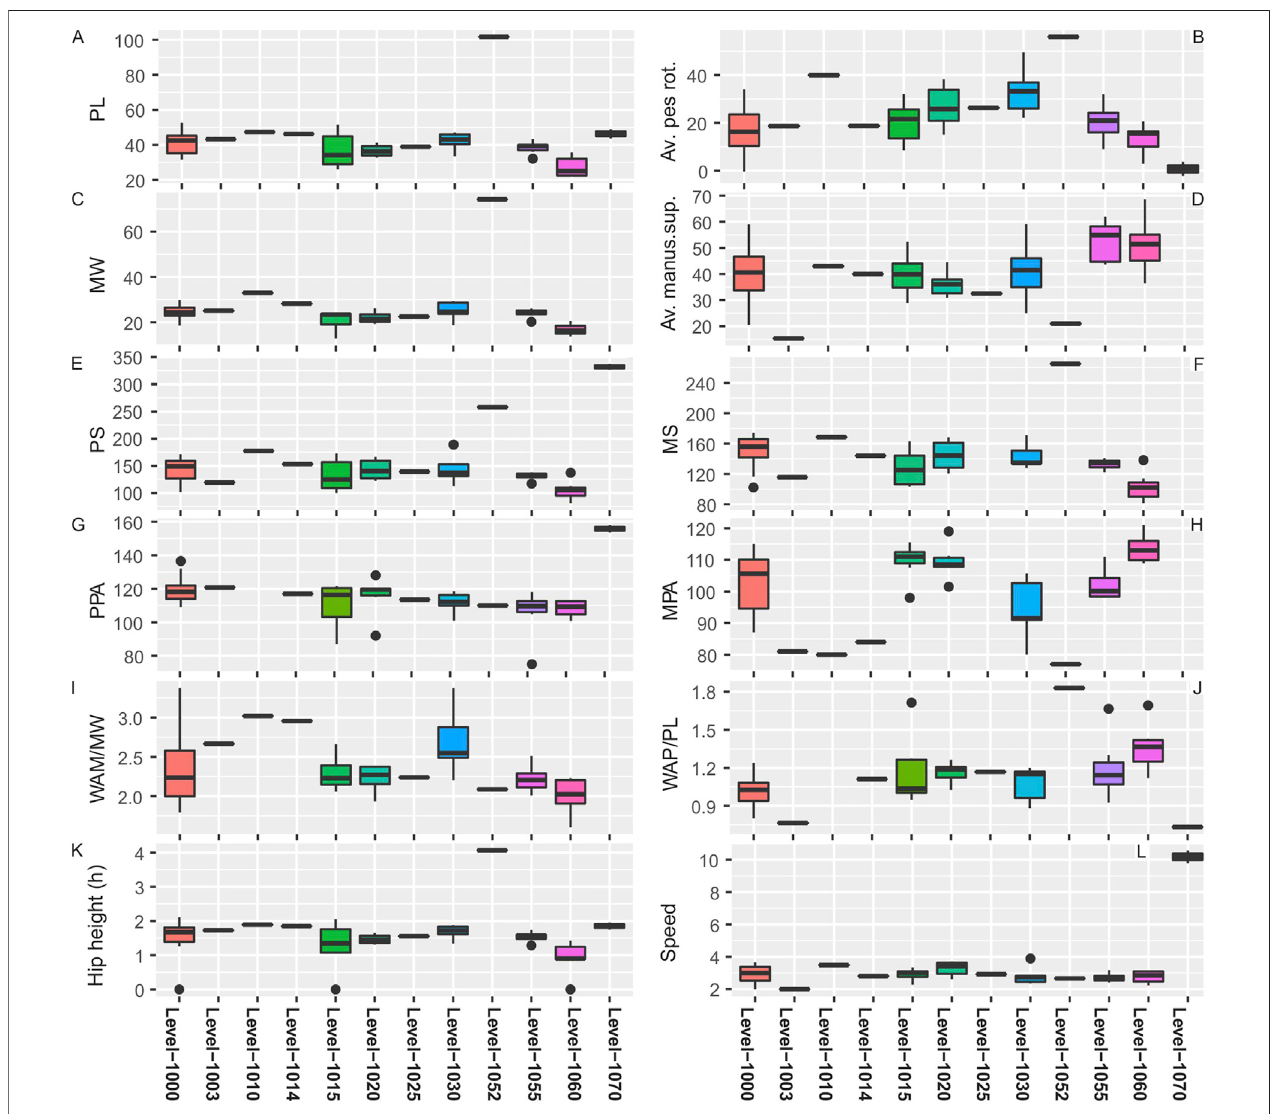
FIGURE3|(A – L) BoxandwhiskerplotsofallTCHtracksitedatabytrackandtrackwayparametersforeachstratigraphictracklevel(Level1000-1070).Acronyms as per text.